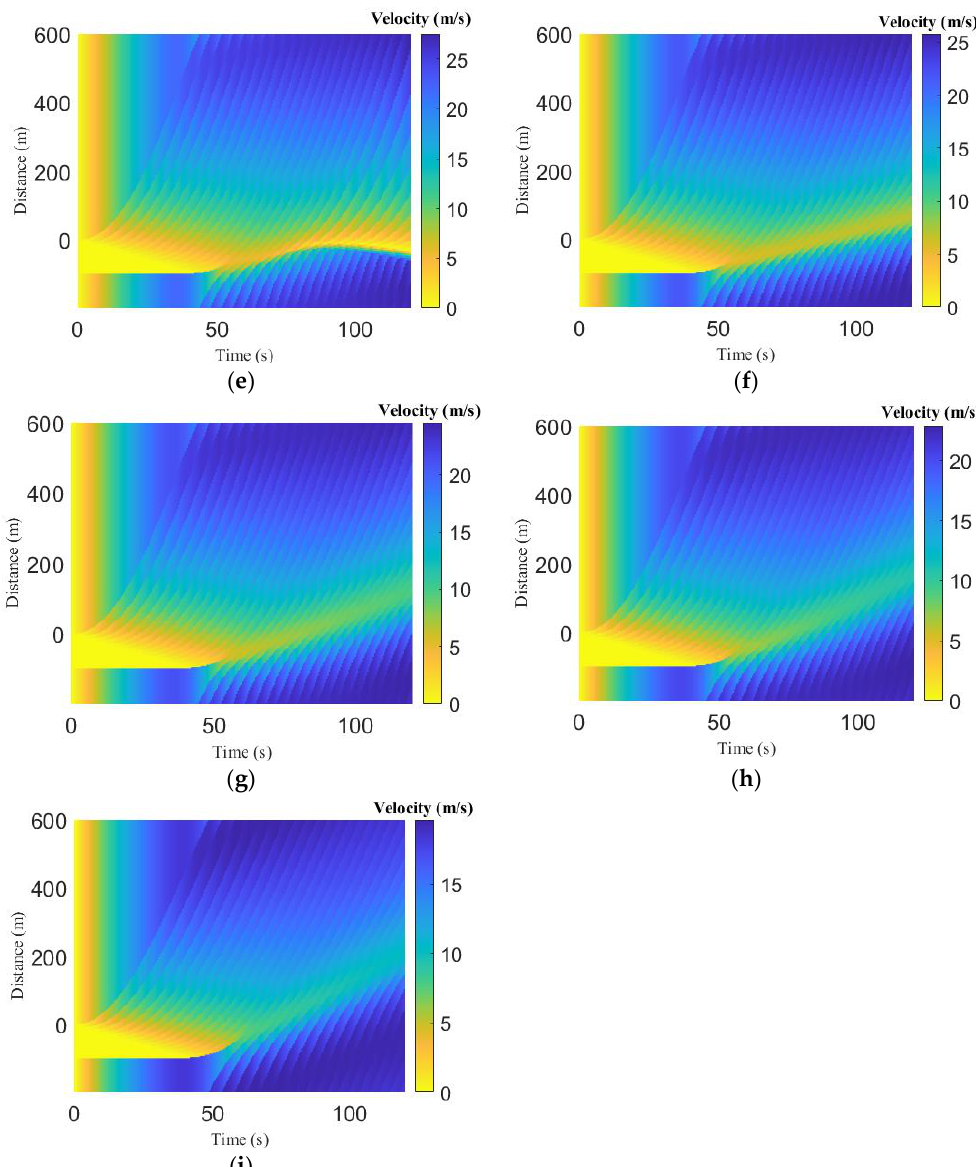
Figure 4. Time-space velocity evolution for the ID and proposed models over an 800 m circular road: ( a ) ID model, 𝛿 = 1 ; ( b ) ID model, 𝛿 = 4 ; ( c ) ID model, 𝛿 = 20 ; ( d ) proposed model, 𝛼 = 0 ; ( e ) pro- model, 𝛼 = 0.8 ; ( i ) proposed model, 𝛼 = 0.9 . Table 5. Velocity and time for the ID and proposed models during the queue and after the queue dissipates.